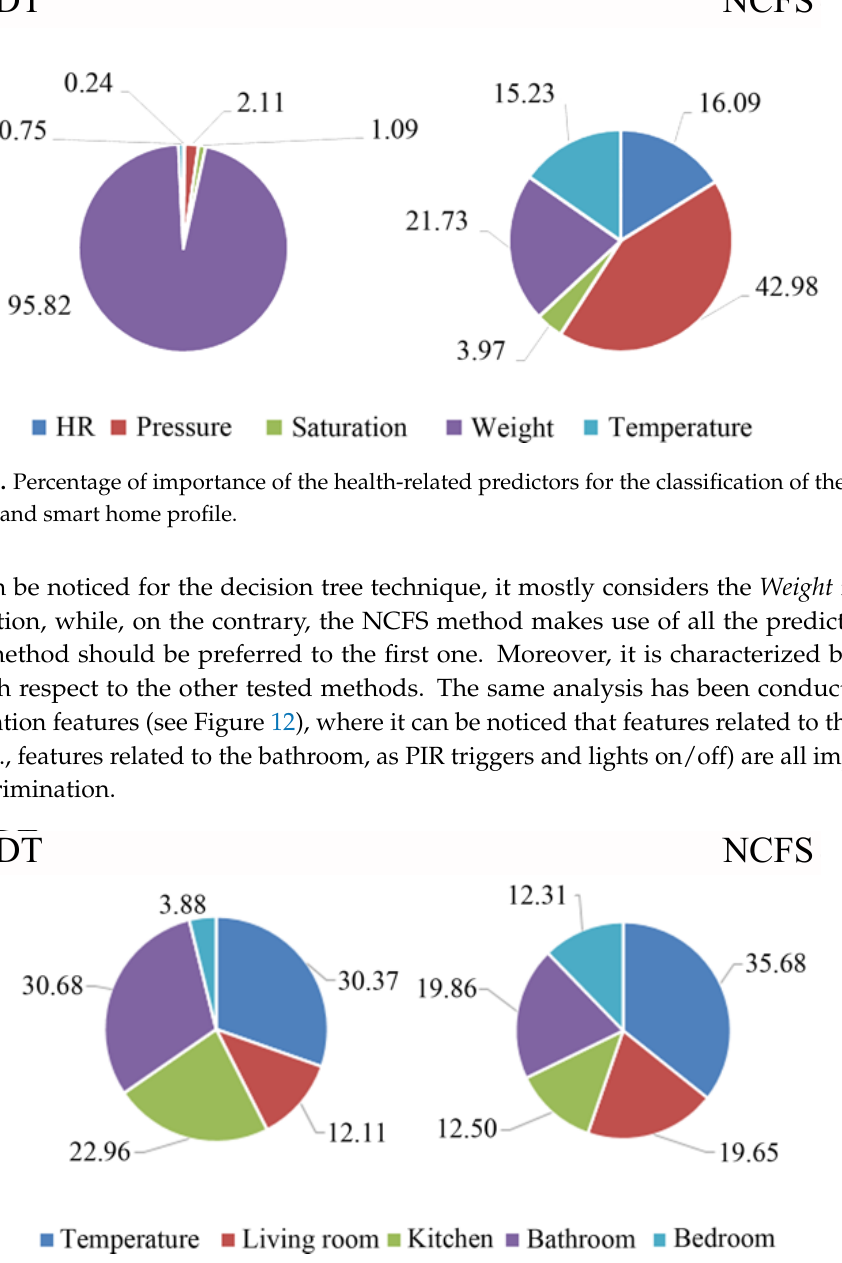
Figure 12. Percentage of importance of the home automation-related predictors for the classification of the users’ behavior and smart home